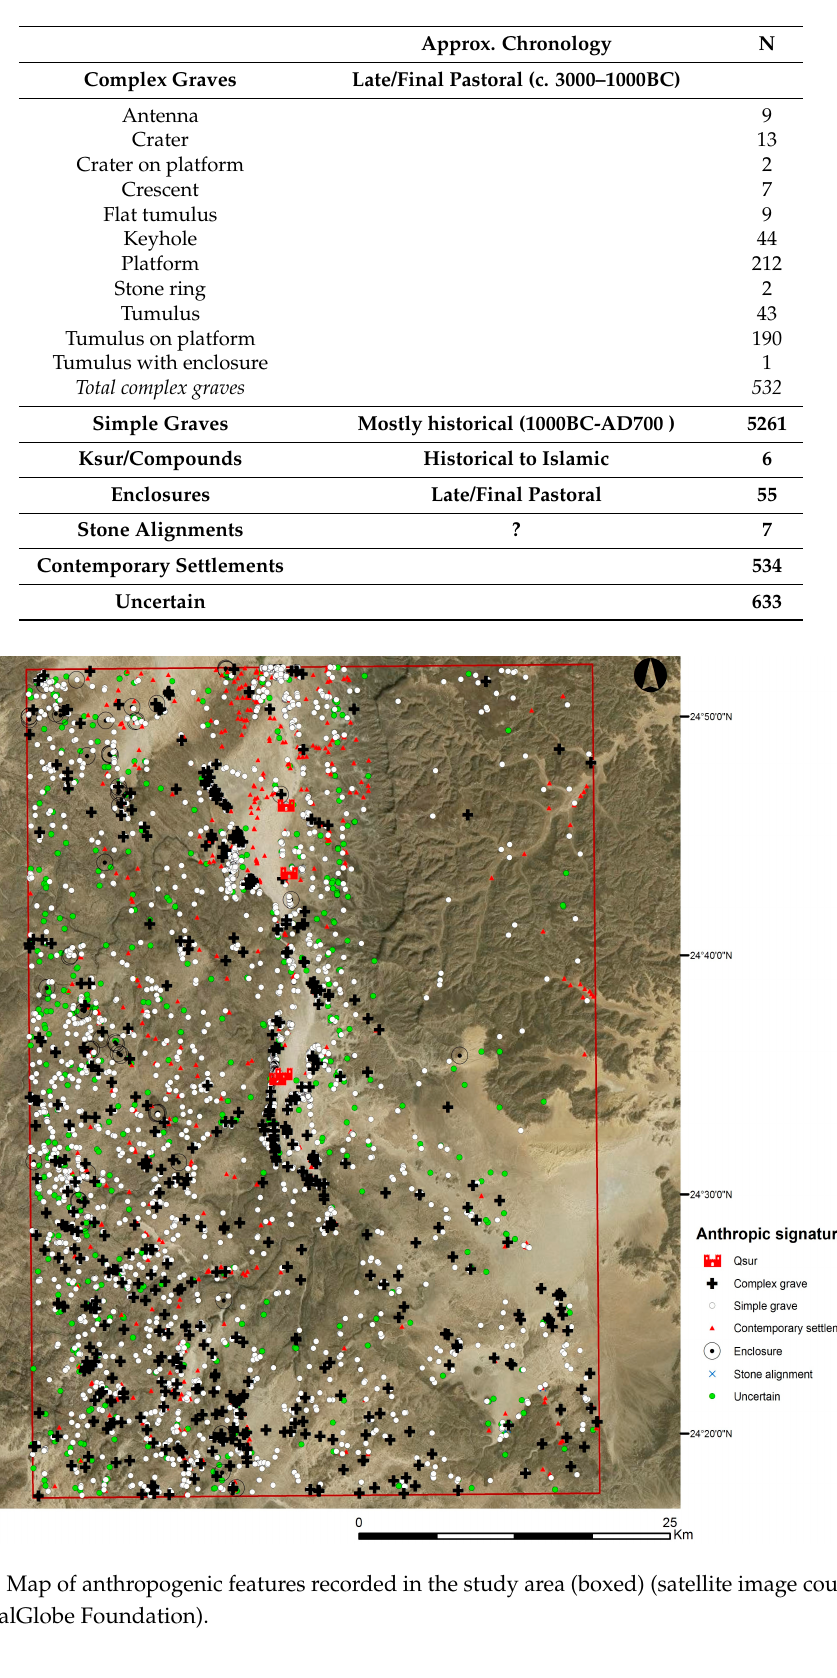
Table 5. Summary of different anthropogenic features identified in this study.